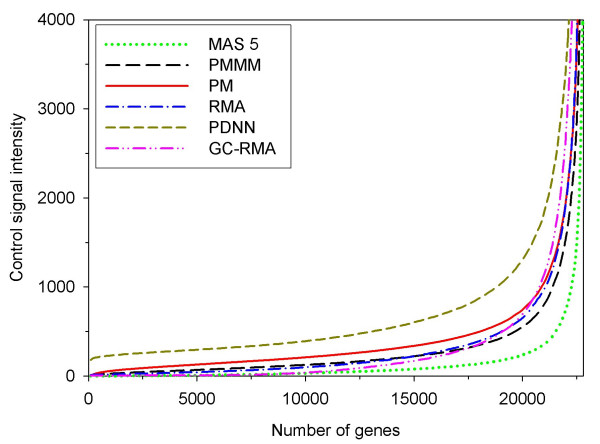
Gene signal intensity. Gene signal intensity from control plants of all genes (22747) calculated with six methods, MAS 5.0 (MAS), dChip PMMM (PMMM), dChip PM only (PM), RMA, GC-RMA and PDNN. The signal intensity is sorted from low to high. Similar results where observed with expression data from treated plants.